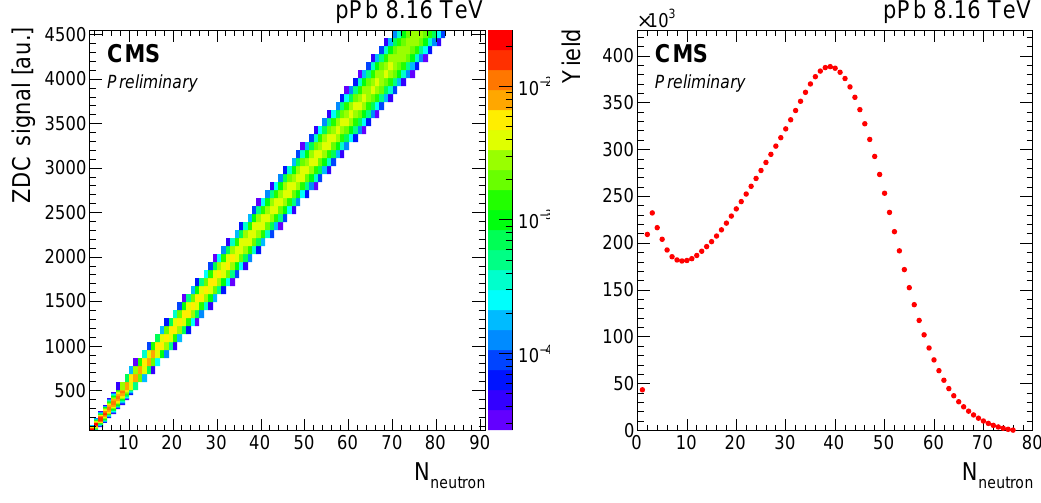
Figure 8. Response matrix ( left ) and the unfolded neutron multiplicity distribution ( right ).